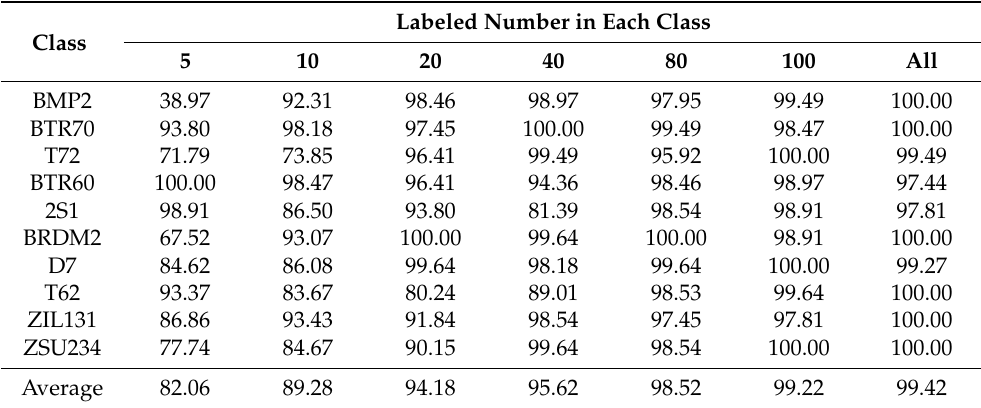
Table 3. Recognition accuracy (%) of SOC under different numbers of labeled images in each classes.